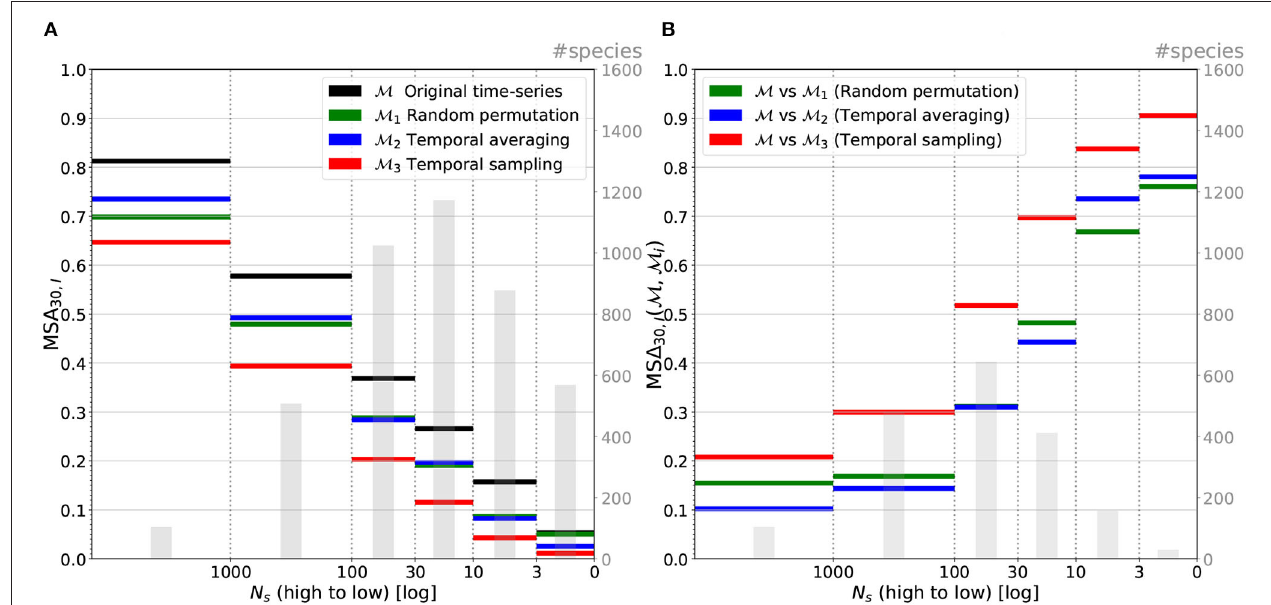
FIGURE 9 | Macro-average top-30 accuracy (A) and relative top-30 accuracy change (B) averaged per category of the number of species occurrences in the training set. All models, performances are following the drop of N s when relative performance changes are inversely proportional to